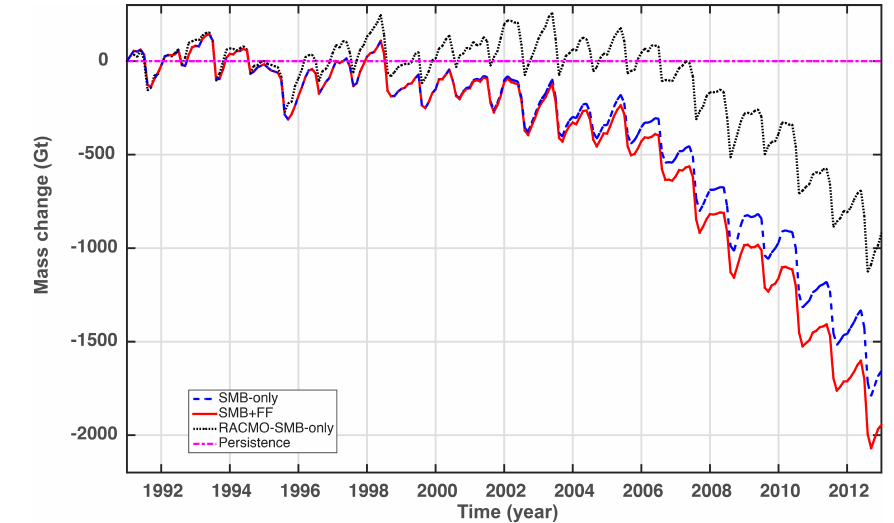
Figure 4. Modeled ice sheet mass change (Gt) vs. time relative to the initial condition. Different line types represent different simulations and models, as identified in the